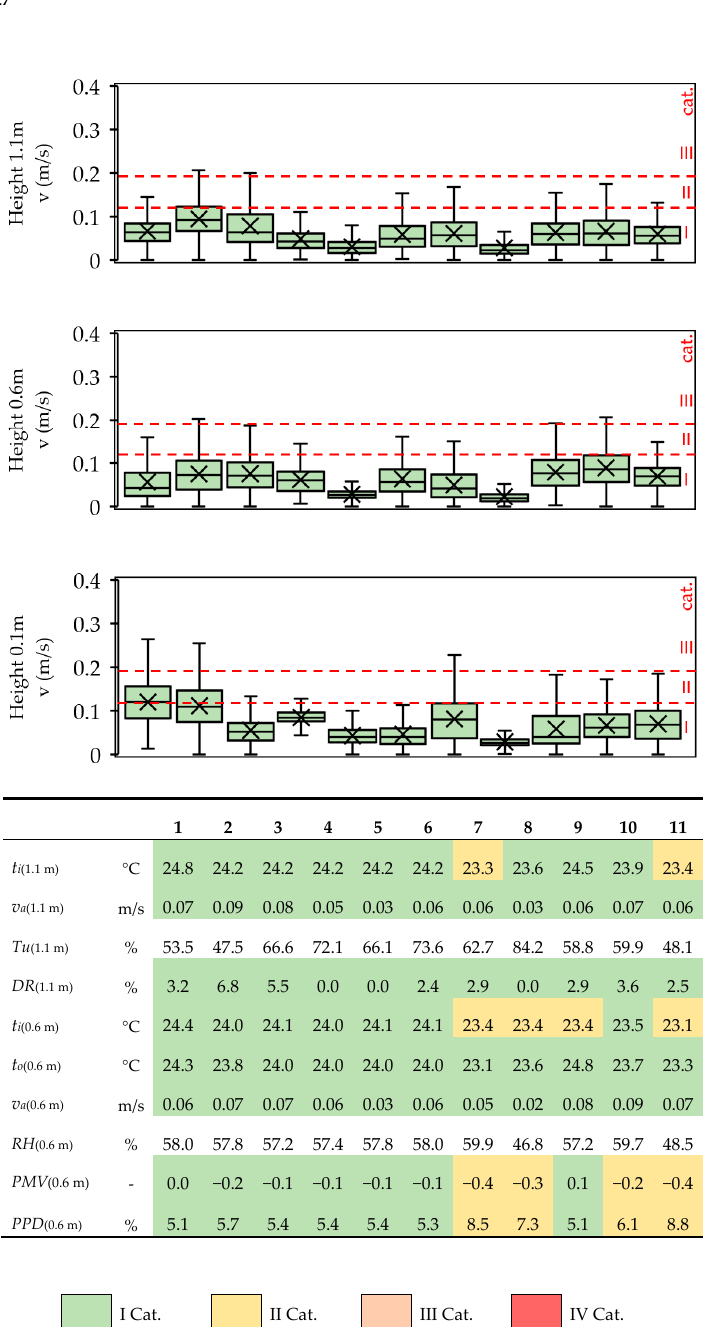
Figure 7. Building D air velocity results in measurement points 1–11 and the thermal comfort Figure7. parameters.